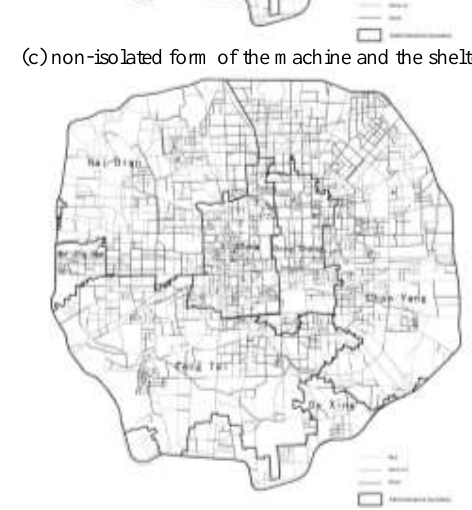
Figure 9. Partitioned assessment map of Road